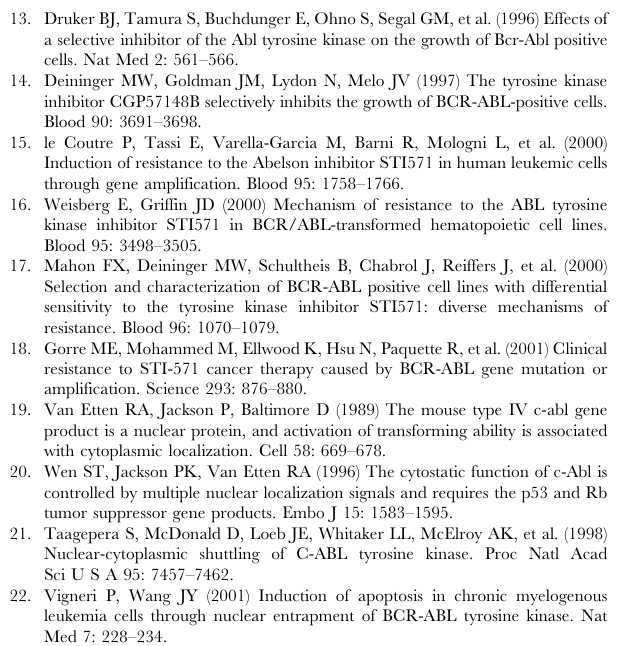
indicated constructs of BCR-ABL proteins in the p185-BCR-ABL backbone were transiently expressed in murine embryo fibroblasts isolated from Abl-null mice, and their subcellular distribution was assessed by indirect immunofluorescence using the anti-ABL 8E9 antibody, without or with treatment with LMB (10 nM, 6 hr.). Detection of nuclear signals indicates re-activation of the NLS function by the specified mutations. The substitution of BCR Tyr177 with phenylalanine did not re-activate the NLS function, nor did the deletion of the BCR 14-3-3-binding site. The NLS function is re-activated in the kinase-defective p185-BCR-ABL. Figure S2 BCR-ABL does not affect the nuclear import and GFP-tagged ABL expression constructs and treated without or with LMB (10 nM, 6 hr.). The anti-HA staining (red) shows the subcellular distribution of BCR-ABL, and the GFP (green) fluorescence shows the subcellular localization of ABL. Nuclei are counterstained with Hoechst dye (blue). Figure S3 Mutation of tyrosines 115, 185, 226, 264, 393 and 469 does not inhibit the NLS function of kinase- defective BCR 63 -ABL. COS cells were transfected with a kinase-defective BCR 63 -ABL-6Y/F, in which six tyrosines in the kinase domain are mutated to phenylalanines as indicated in the schematic diagram (the amino acid numbering refers to that of ABL-1a). The phenylalanine substitutions of these six tyrosines did not inhibit the NLS function as indicated by the nuclear accumulation of BCR63-ABL-6Y/F after treatment with LMB